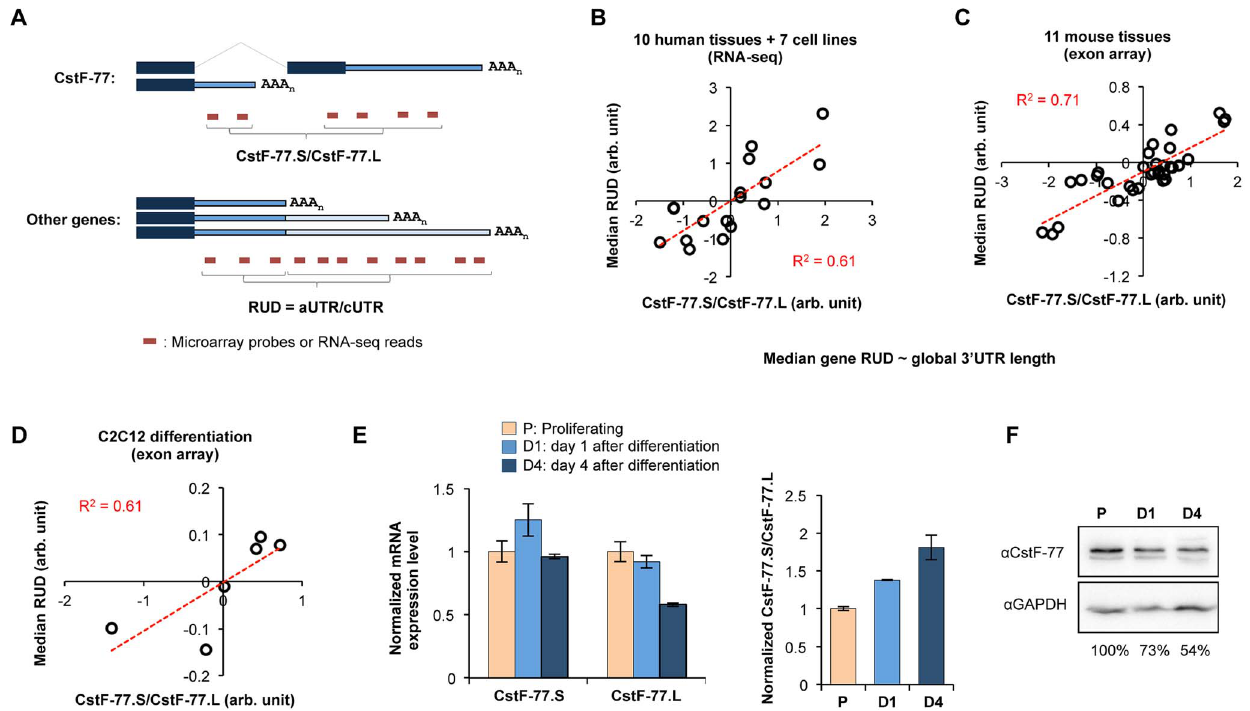
Figure 4. Intronic C/P of human and mouse CstF-77 genes correlates with the global 3 9 UTR length. ( A ) Analysis of the CstF-77.S/CstF- 77.L ratio and global 3 9 UTR length regulation (RUD) using microarray and RNA-seq data. cUTR, constitutive UTR; aUTR, alternative UTR. Correlation of the CstF-77.S/CstF-77.L ratio with global 3 9 UTR length was found in 17 human tissues and cell lines ( B ), 11 mouse tissues ( C ), and proliferating and differentiating C2C12 cells ( D ) as indicated by the R 2 values (linear regression). ( E ) Validation of CstF-77.S and CstF-77.L expression in proliferating and differentiating C2C12 cells by RT-qPCR (left). The normalized CstF-77.S/CstF-77.L ratio is also shown (right). P, proliferating; D1, differentiation for 1 day; D4, differentiation for 4 days. ( F ) Expression of CstF-77 protein in proliferating and differentiating C2C12 cells. The relative amount of CstF-77 is indicated. GAPDH was used as internal control.